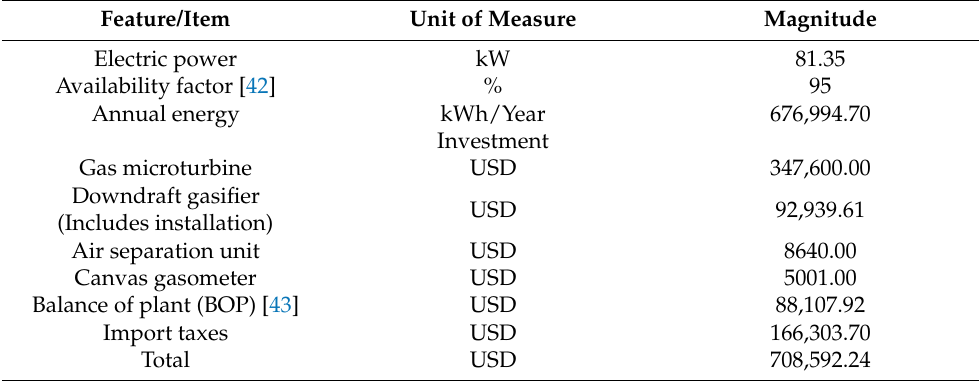
Table 6. Investment required to construct the downdraft gasifier/gas microturbine system using oxygen-enriched air as the gasification agent.